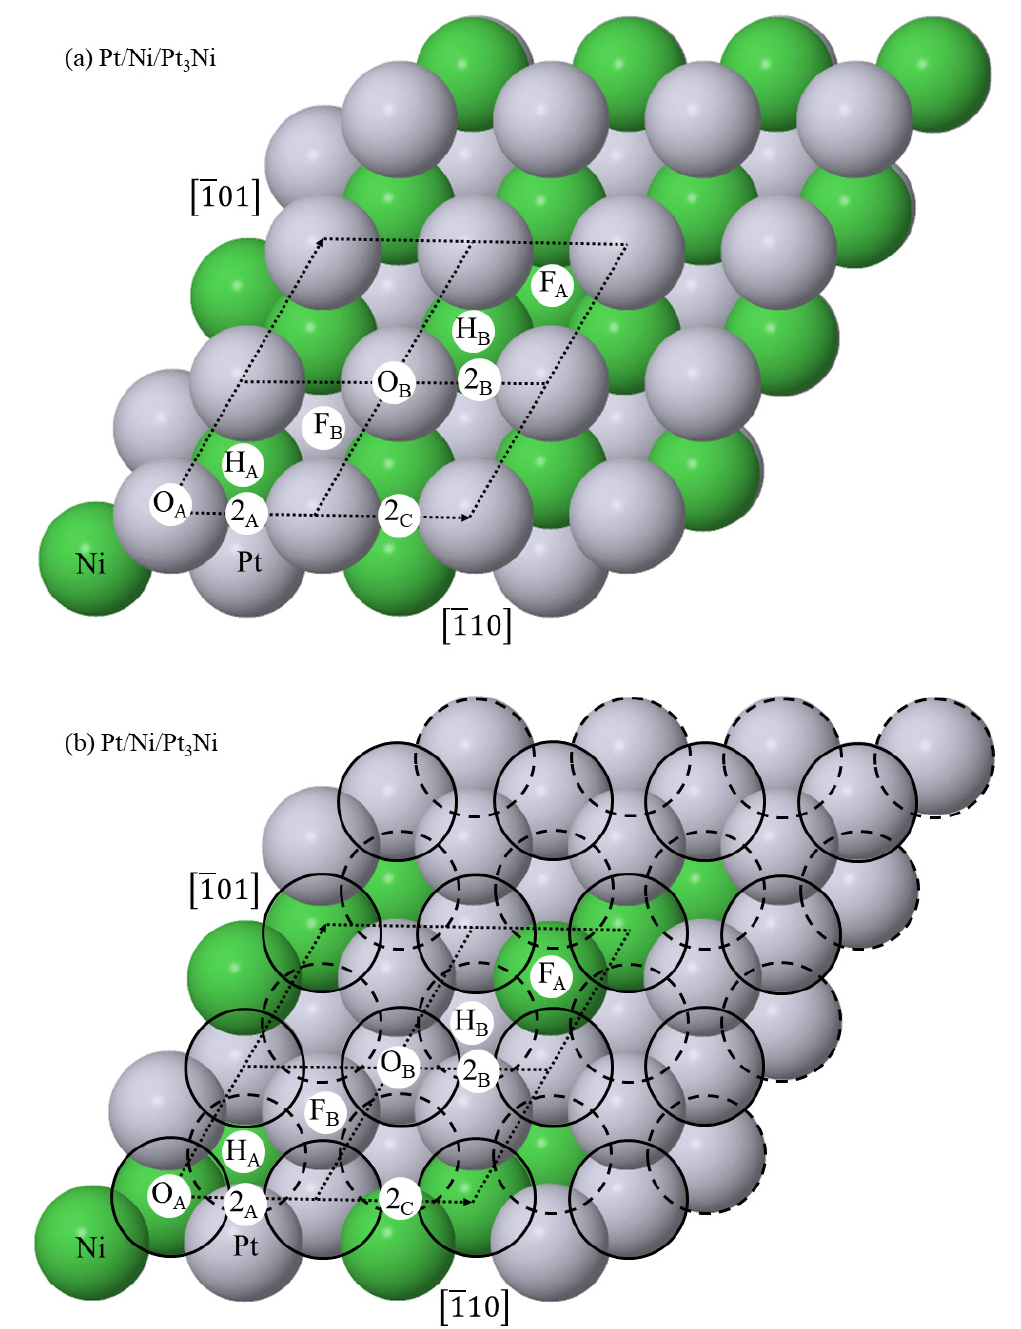
Figure 14. ( a ) The ‘O A ’ and ‘O B ’ on-top, ‘F A ’ and ‘F B ’ FCC, ‘H A ’ and ‘H B ’ HCP and ‘2 A ’, ‘2 B ’ and ‘2 C ’ two-fold bridge high-symmetry binding positions on the reacted Pt/Ni/Pt 3 Ni-(111) surface. In ( b ), the surface and second layers—the pure Pt and Ni layers—are replaced with transparent circles bounded by solid and dashed lines, respectively. The straight dotted lines show the (2 × 2) surface unit cell used in the current simulations. The Pt/Ni/PtNi 3 -(111) is generated by changing every Pt (Ni) atom in layer 3 and deeper for a Ni (Pt) atom.